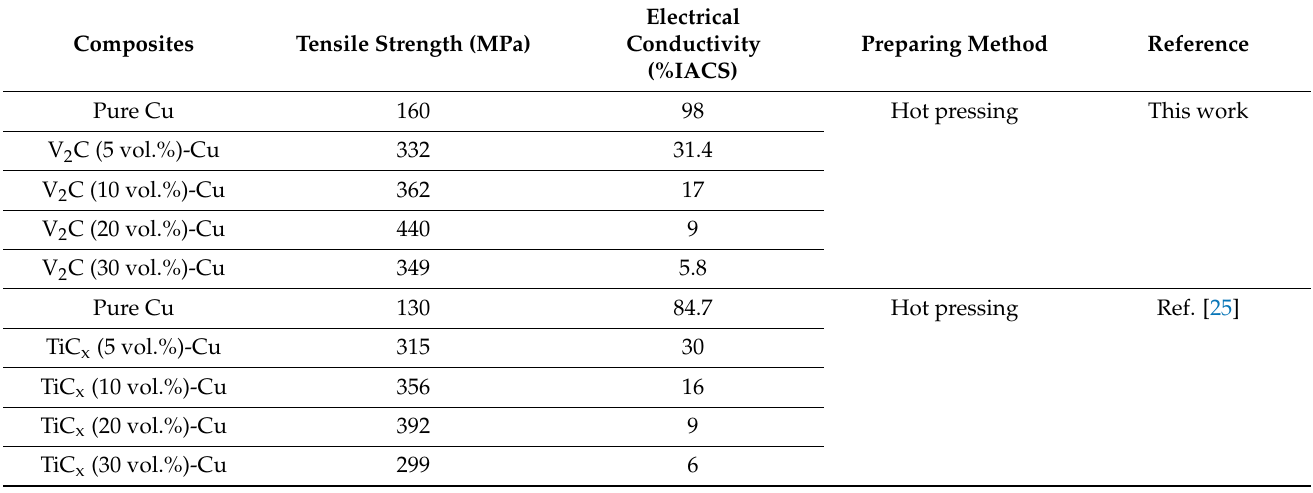
Table 2. Tensile strength and electrical conductivity of the different in situ MX-Cu composites.